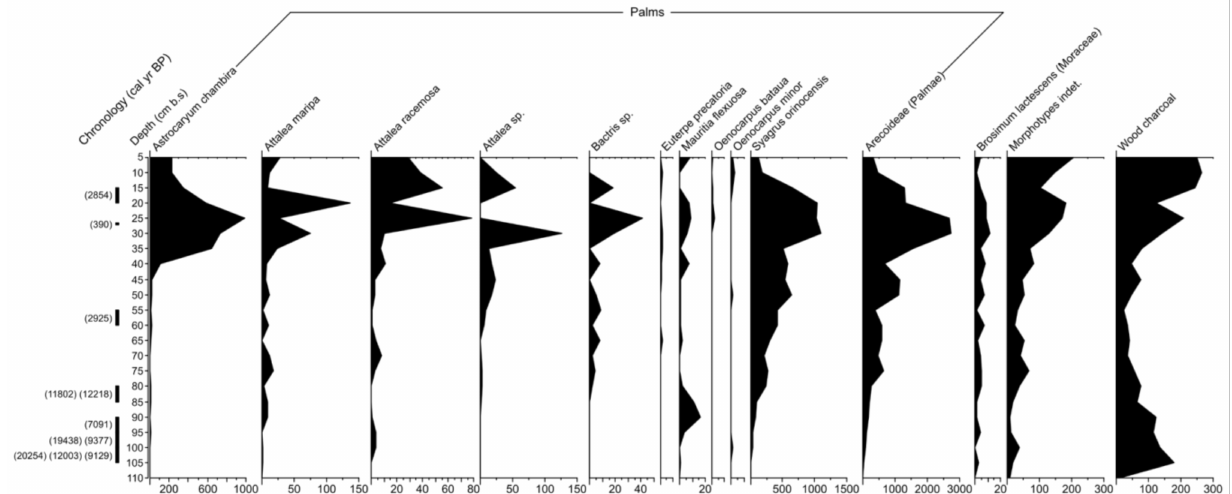
Figure 4. Diagram of macrobotanical remains from Excavation Unit 1 from Cerro Azul. Macrobotanical remains were analyzed from arbitrary 5 cm levels collected during excavation. Data are presented by depth below surface. Reprinted from Morcote-Rios et al. [18], with permission from